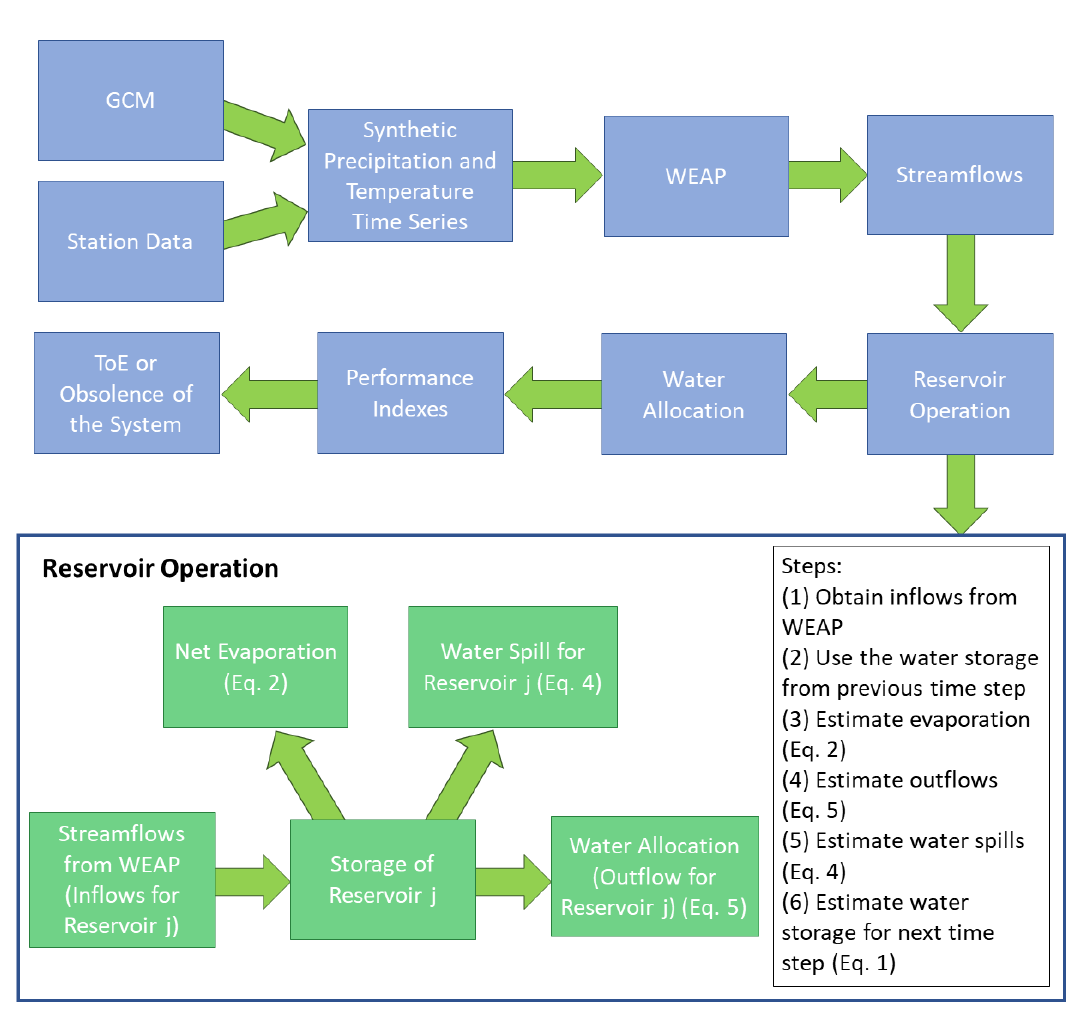
Figure 2. Schematic representation of the methodology. The general flow chart is presented in the upper part, and the detail of the reservoir operation are shown in the lower part.